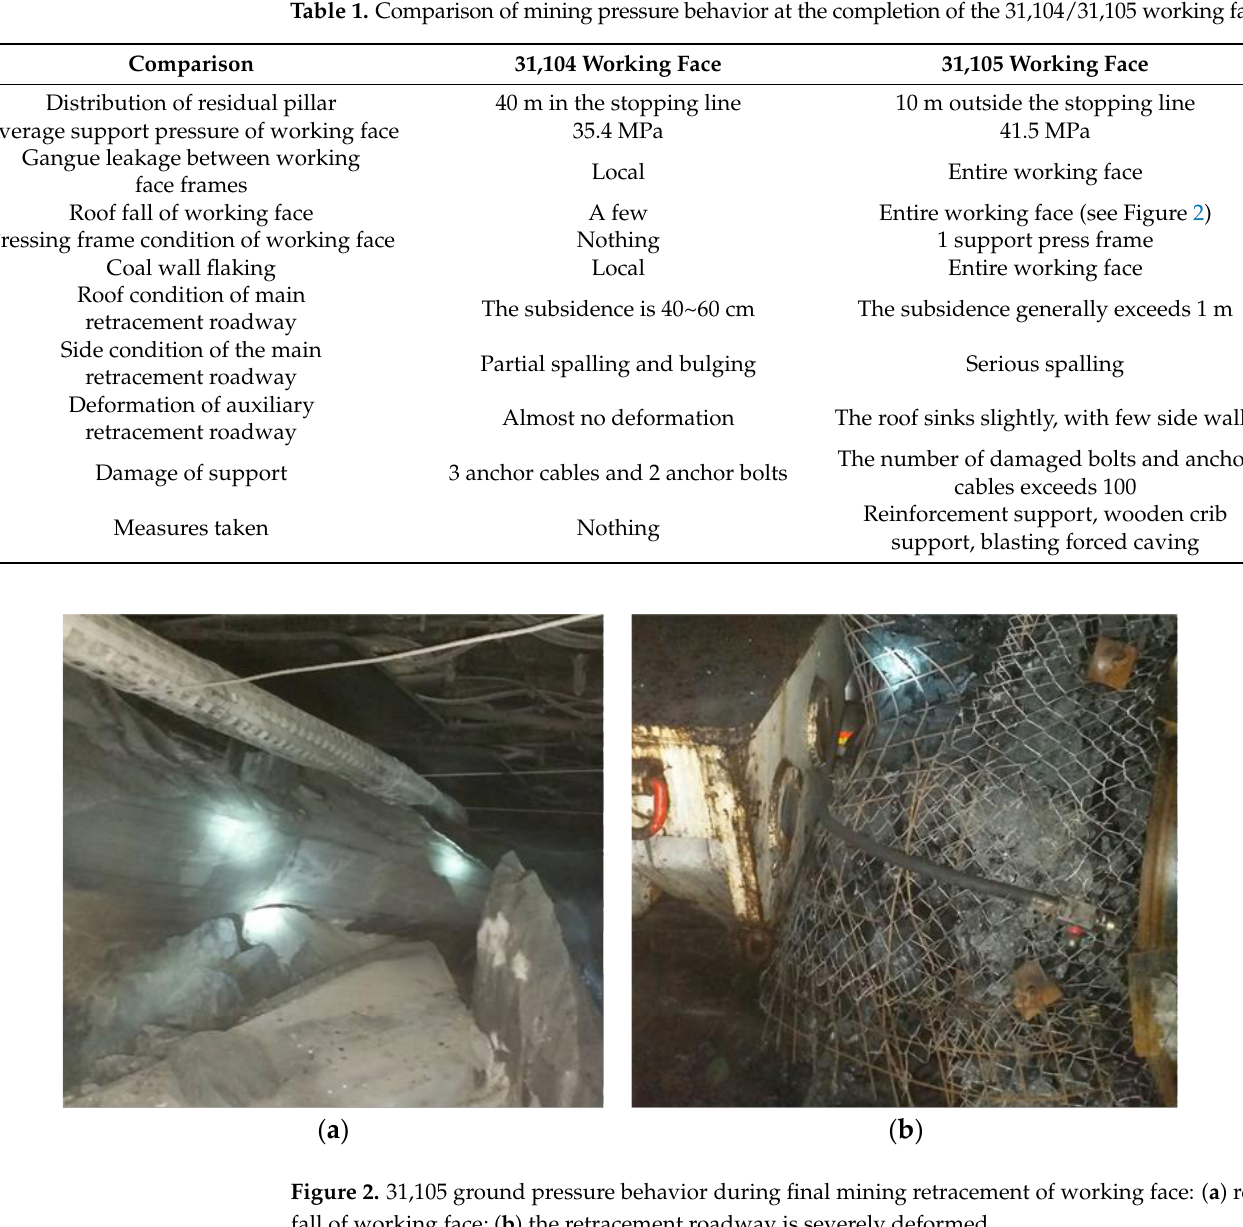
Table 1. Comparison of mining pressure behavior at the completion of the 31,104/31,105 working face.